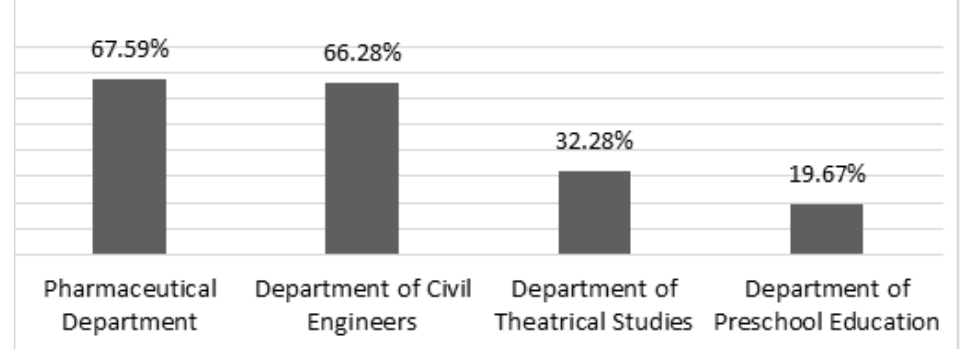
Figure 3. Percentage of students with a father who is a higher education graduate or has postgraduate studies by university department (University of Patras).